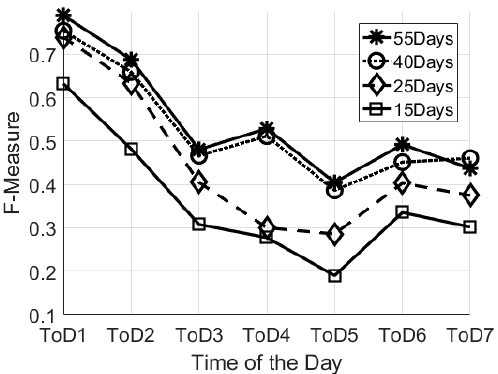
Figure 2. Comparison of the different learning set configurations by Means of F-Measured over different times of the day. Table 2. Summary of features used in the analysis. M is the mean values and SD is the standard deviation computed for a specific “Times of the Day” ToD, whereas TE is the “Time between events”. Features